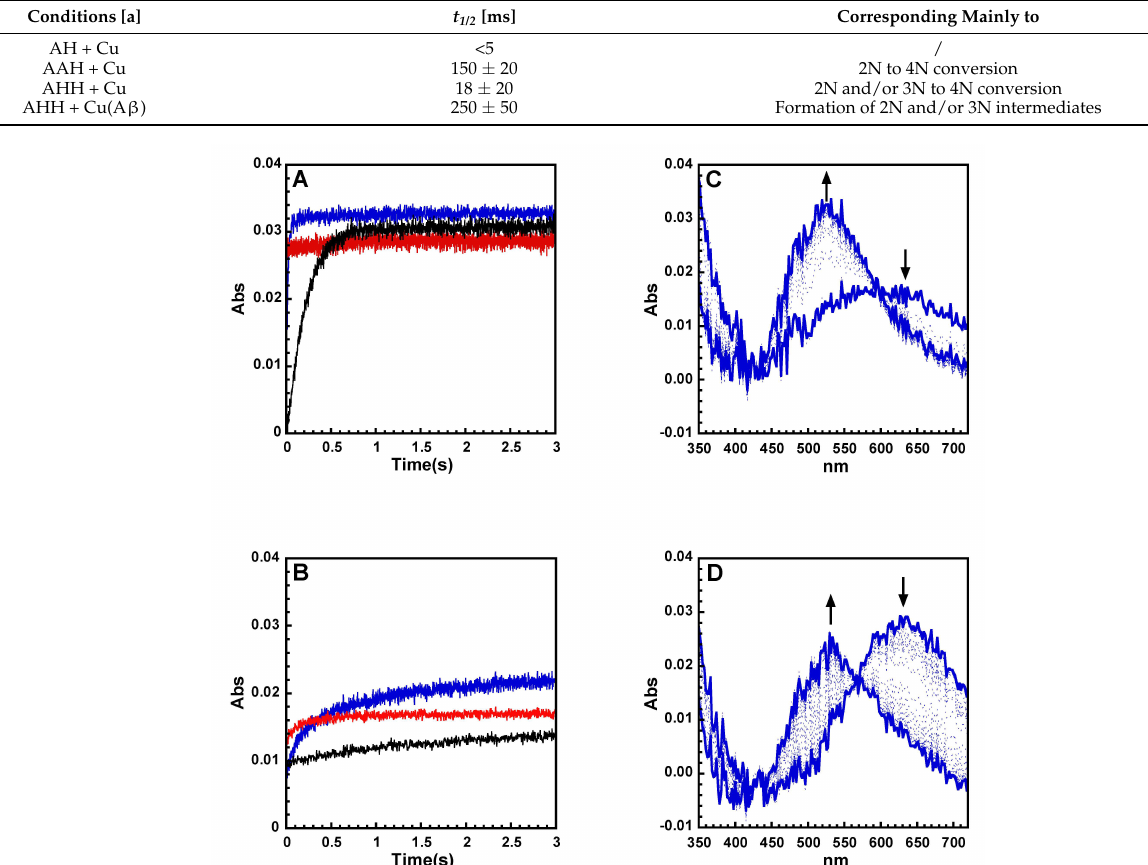
Figure 3. Stopped-flow kinetic traces of Cu II coordination by the peptides AH (red), AAH (black), and AHH (blue) (panel ( A ) (Cu II only); panel ( B ) (Cu II (A β )) and selection of corresponding UV–Vis spectra (panels ( C ) and ( D ), respectively). The absorption was measured at 590 nm for AH and at 530 nm for AAH and AHH. Measurements were performed in 100 mM HEPES buffer (pH 7.4) at 25 ◦ C. Final concentrations: [Cu II ] = 450 µ M, [peptide] = [A β ] = 500 µ